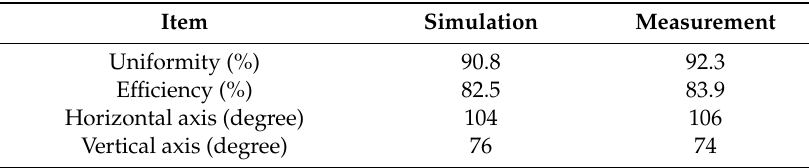
Table 8. Comparison of simulation and measurement